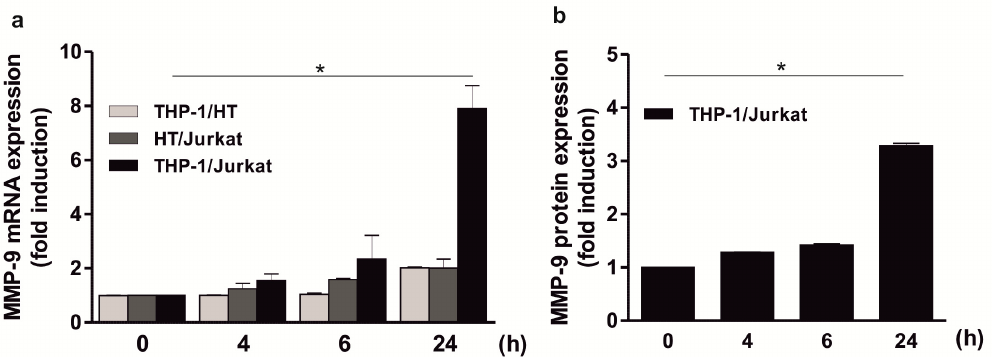
Figure 3. Induction of MMP-9 expression by HMWH in a THP-1 and Jurkat cells containing co-culture. 1 × 10 6 THP-1 and HT, HT and Jurkat, or THP-1 and Jurkat cells per well (i.e., a total of 2 × 10 6 cells/well) were starved overnight and then stimulated with 50 IU/well HMWH up to 24 h. MMP-9 mRNA ( a ) and protein ( b ) expression were determined using qPCR (QuantiTect Custom Assay; housekeeping gene: GAPDH) and ELISA (MMP-9 Quantikine Kit); mean ± SD, n = 3 (measured in duplicates). Kruskal–Wallis test, * p ≤ 0.05.